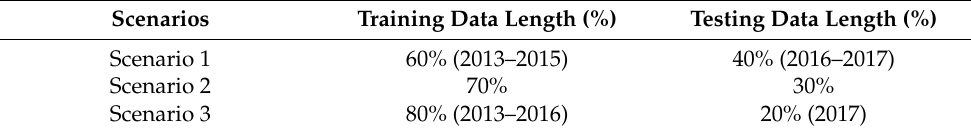
Table 3. Different scenarios of training and testing datasets used in this